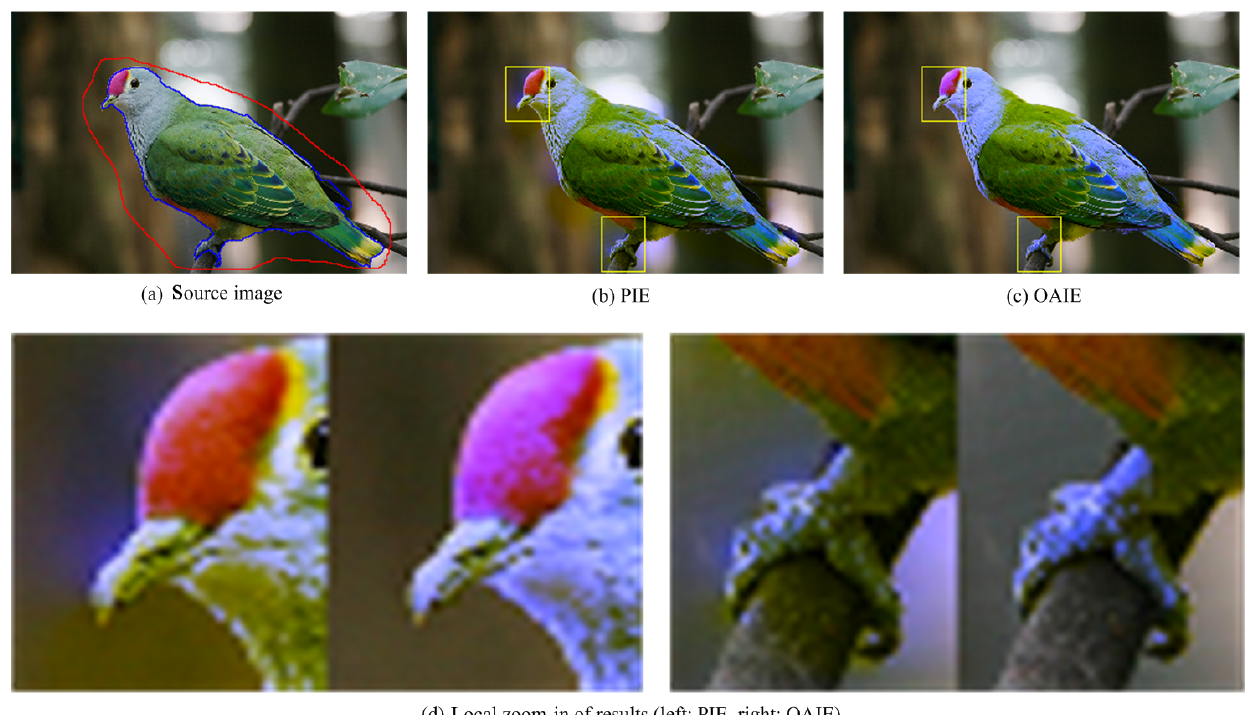
Fig. 5 Selective modification for changing colors of a target of interest. OAIE can provide a smooth transition across image edges without color bleeding and texture blurring, while the PIE result exhibits color bleeding artifacts around the object.